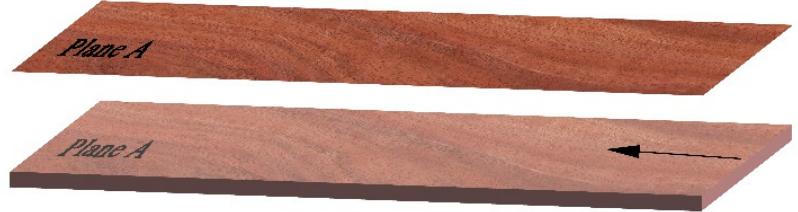
Figure 1. Scanning direction of wood specimens.